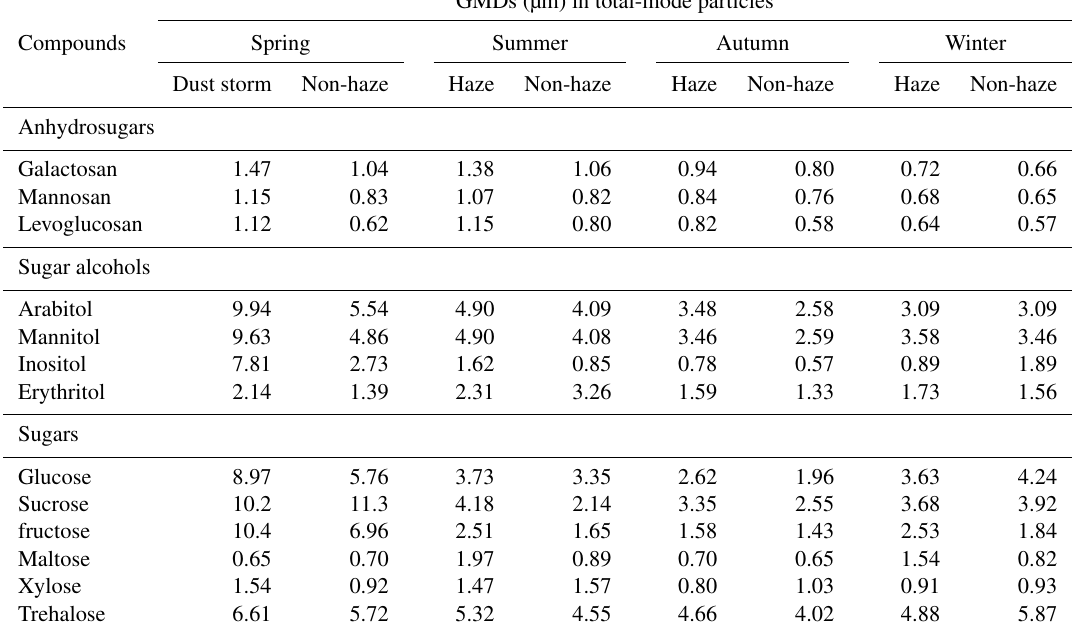
Table 4. Geometric mean diameters (GMDs,µm) of anhydrosugars and other saccharides in the total-mode particles in Beijing from April 2017 to January 2018. GMD: logGMD = ( (cid:80) C i log D pi )/ (cid:80) C i , where C i is the concentration of a compound in size stage i and D pi is the geometric mean diameter of particles collected on stage i